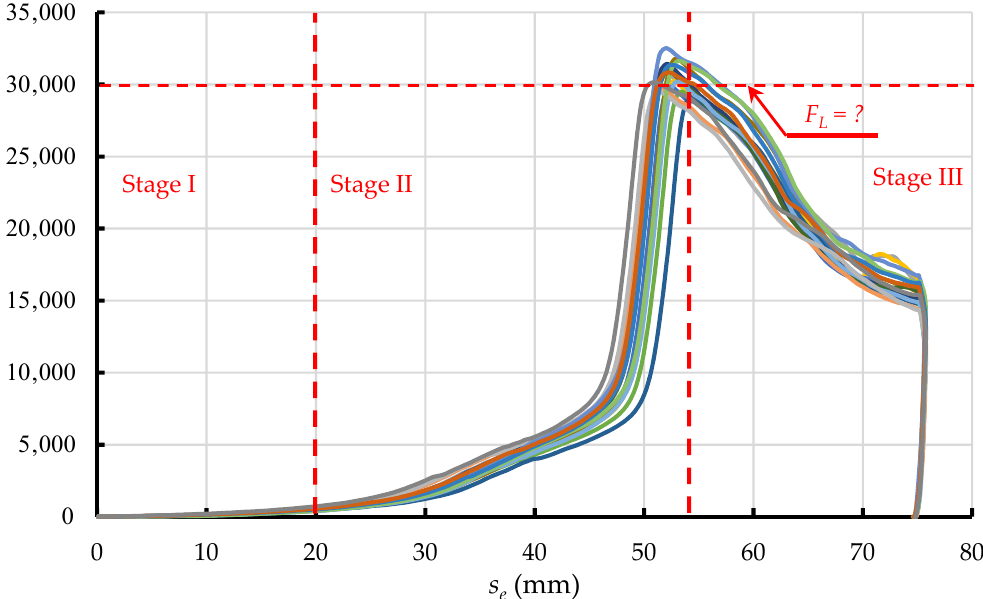
Figure 11. Relationships of the resistance force F e vs. ram displacement s e during extrusion of dry ice snow through WKWP70-50 single-hole die, showing division into phases of the process (different colours means the following samples).